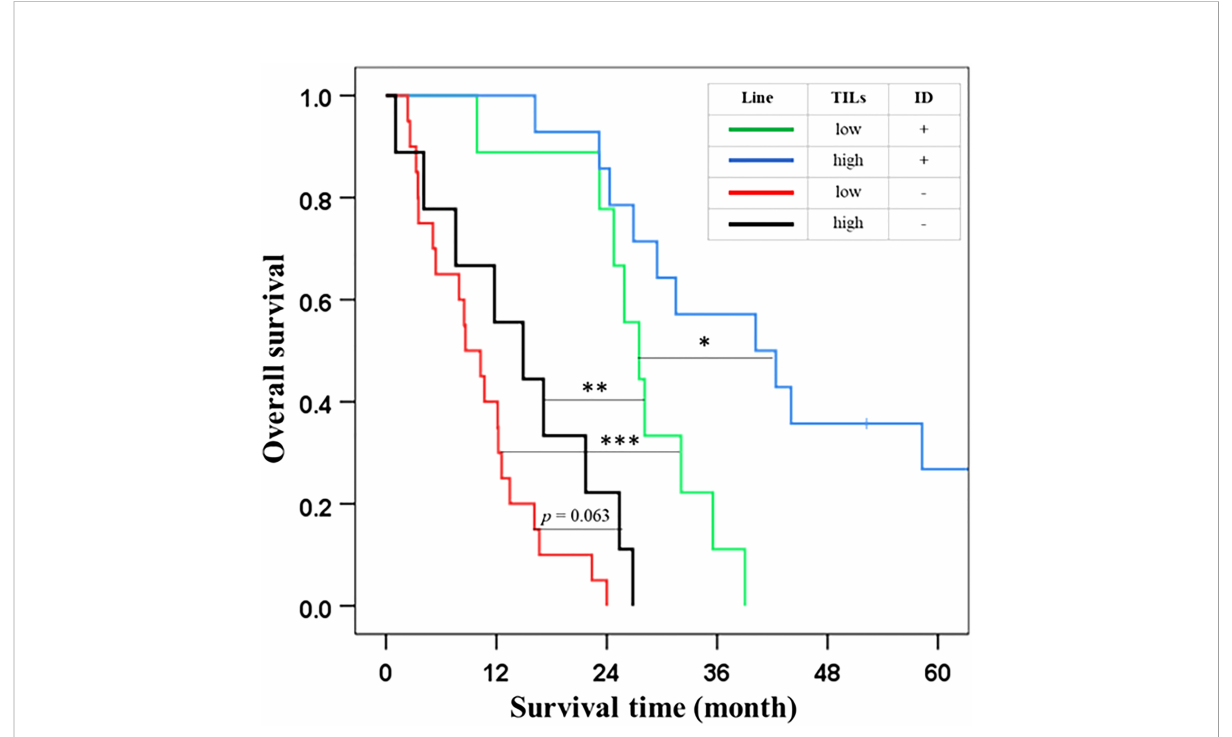
FIGURE 3 The outcome of patients with distal cholangiocarcinoma by subgroup analysis on incorporation TIL levels and growth pattern. Each line represents a combination of TIL levels and growth pattern appearance. The asterisks *, **, and *** indicate p < 0.05, 0.01, and 0.001, respectively.